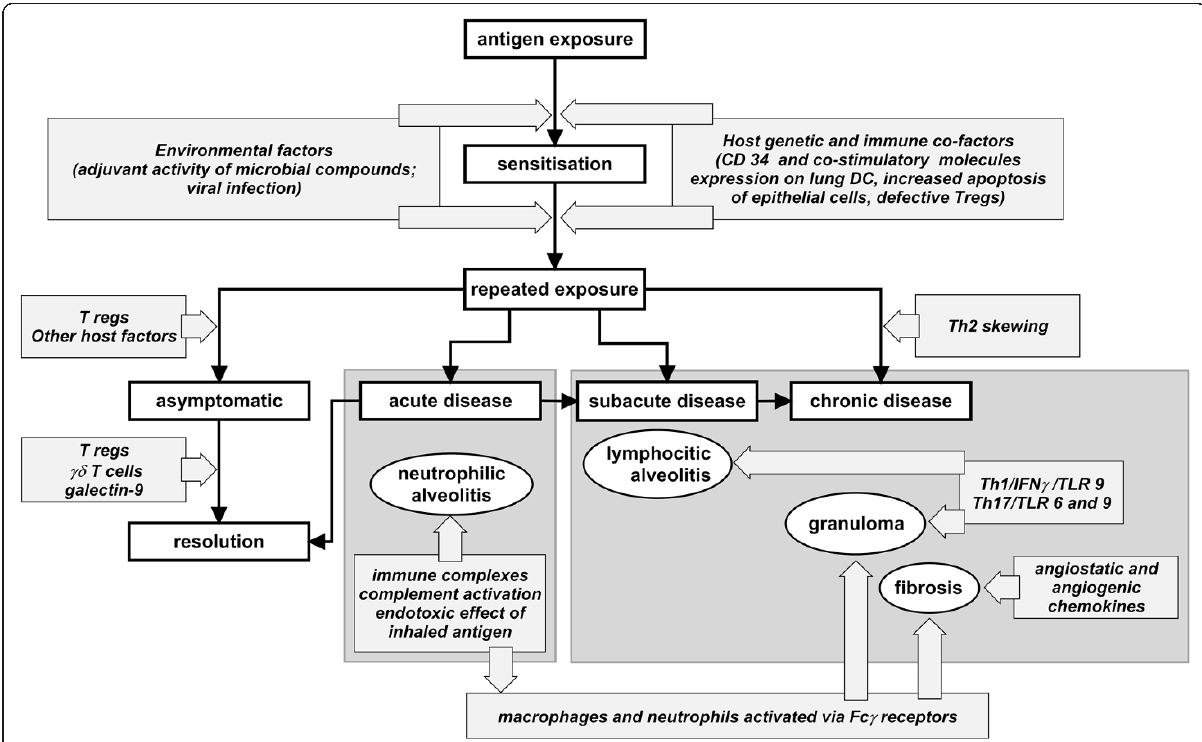
Figure 1 Pathogenenic mechanisms in hypersensivity